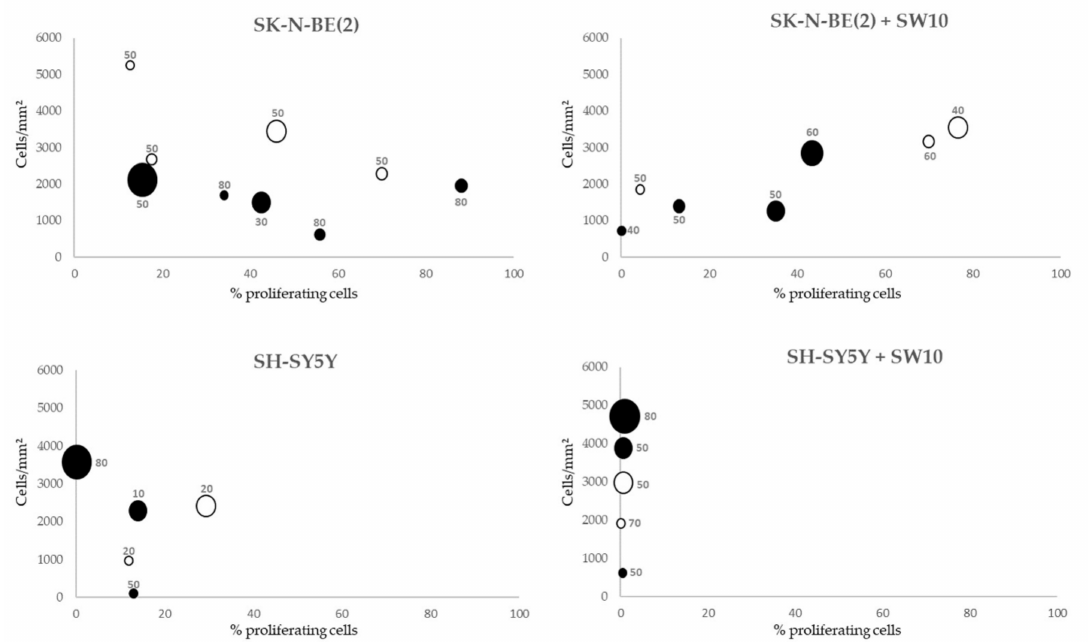
Figure 3. Correlation between proliferative index, cell number, and karyorrhexis index of each cell composition model and time of culture. White circles: soft models. Black circles: sti ff models. Karyorrhexis index is shown for each culture condition. X axis: %Ki67 positive cells. Y axis: total number of cells / hydrogel area (mm 2 ). Circle size is proportional to culture time (2 to 12